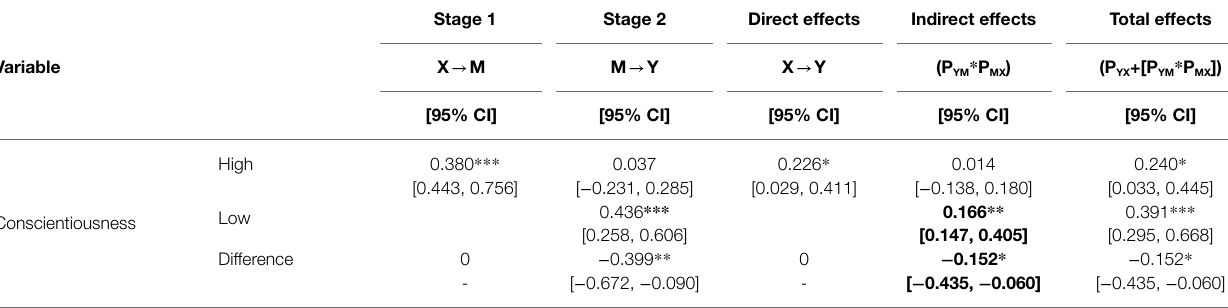
TABLE 5 | Analysis results of moderated mediation effect